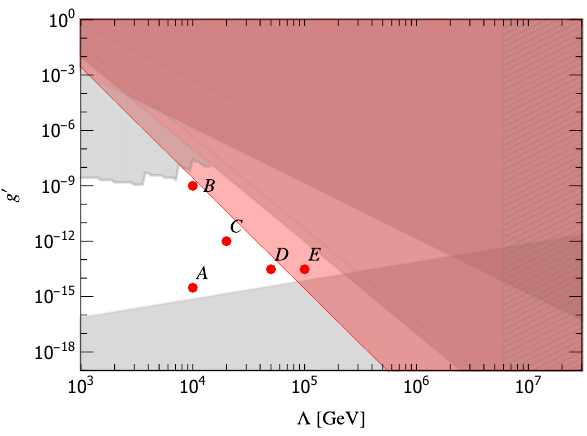
Figure 7 . Case of relaxation AFTER in(cid:13)ation with EW gauge boson production as described in section 4.1. White region is the allowed region that was derived in ref. [14] without including the e(cid:11)ect of relaxion fragmentation. The red region is the new exclusion due to relaxion fragmentation. independent of the